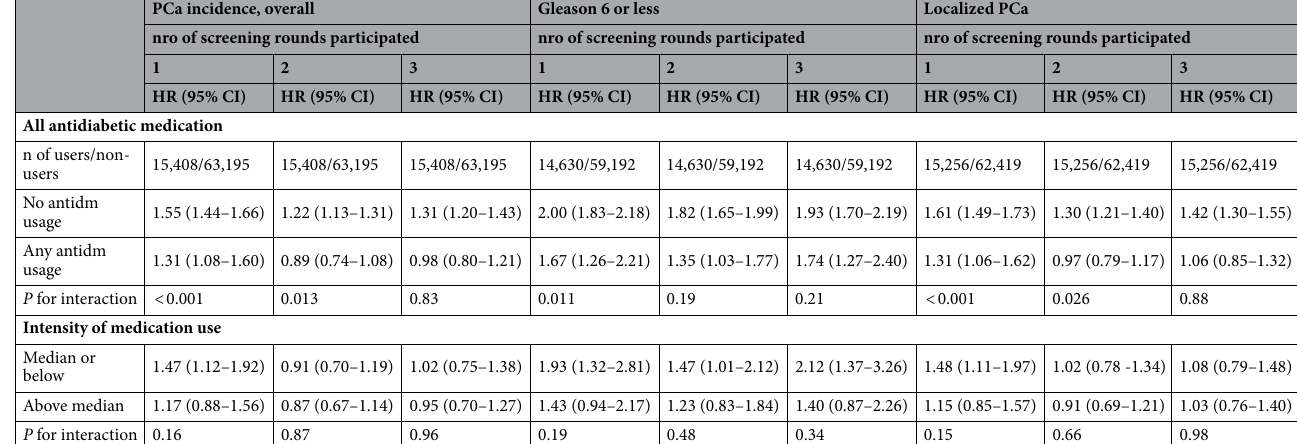
Table 3. Effect of PSA-based screening on incidence of prostate cancer overall and clinically non-significant disease as defined by Gleason score and TNM stage, stratified by antidiabetic medication use. Study population of 78,615 men from the Finnish Randomized Study of Screening for Prostate